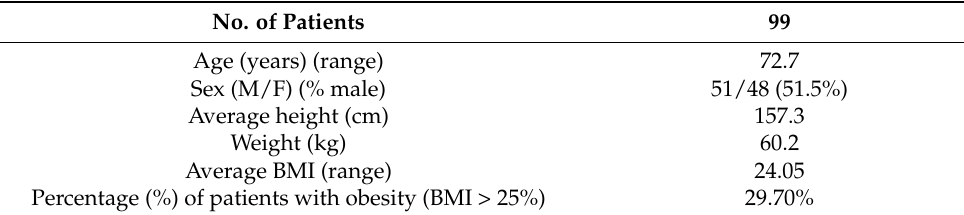
Table 1. Patient demographic